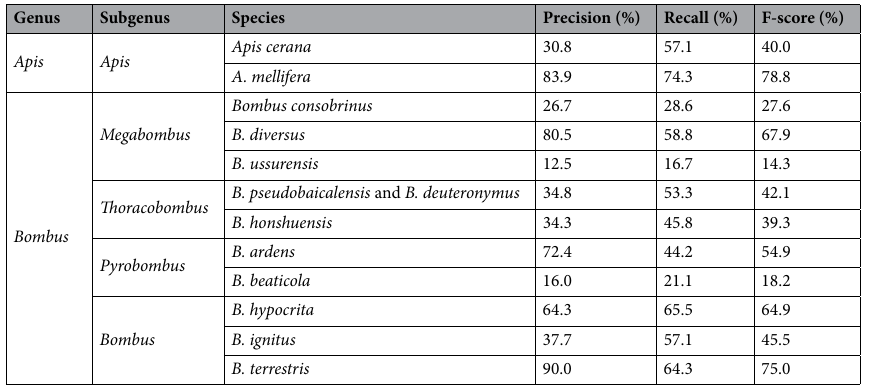
Table 1. Precision, recall, and F-score of species identification by biologists. Precision is the number of correct predictions as a certain class divided by the number of all predictions as the class returned by biologists. Recall, which is equivalent to sensitivity, is the number of correct predictions as a certain class divided by the number of test datasets as the class. F-score is the harmonic average of the precision and recall, (2 × precision × recall)/ (precision + recall).